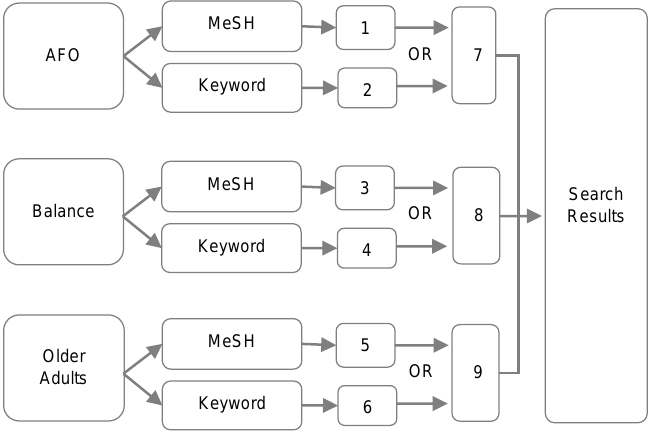
Figure 1: Example database search strategy. Each number represents the database search performed and the results retrieved for each MeSH term and keyword (1-6), the searches combining the corresponding MeSH term and keyword (7,8,9), and the final search results combining all of the terms